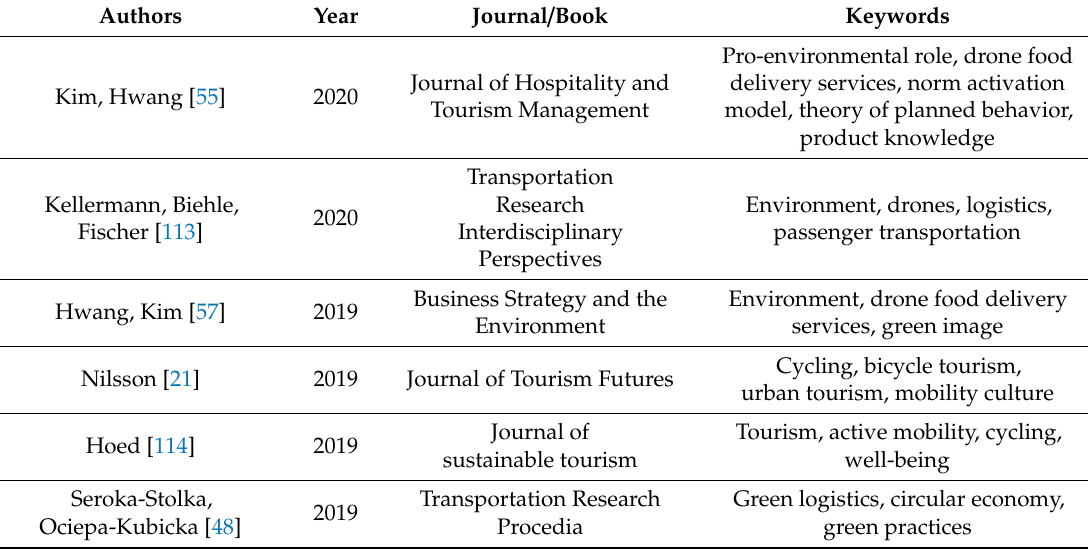
Table 4. Description of literature sources on green solutions for